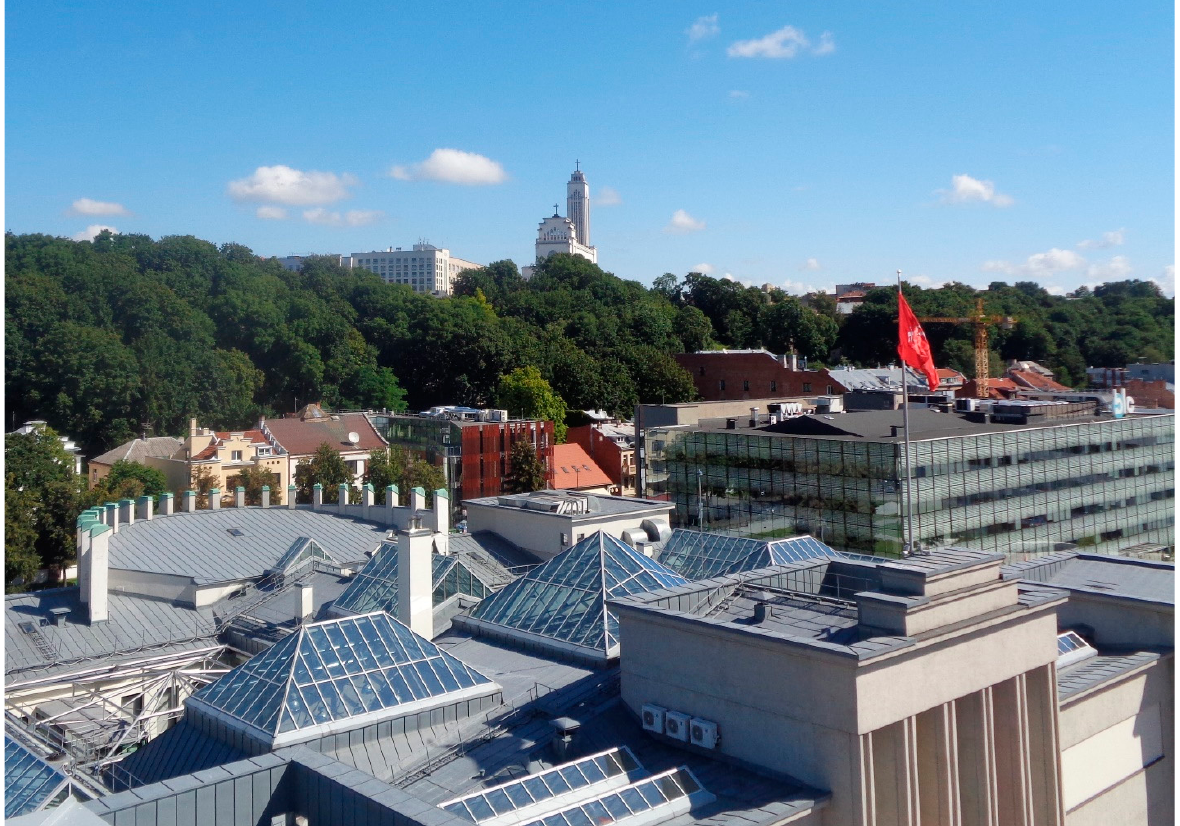
Figure 16. View from Kaunas center, 2022 (photo courtesy of Arvydas Pakštalis).